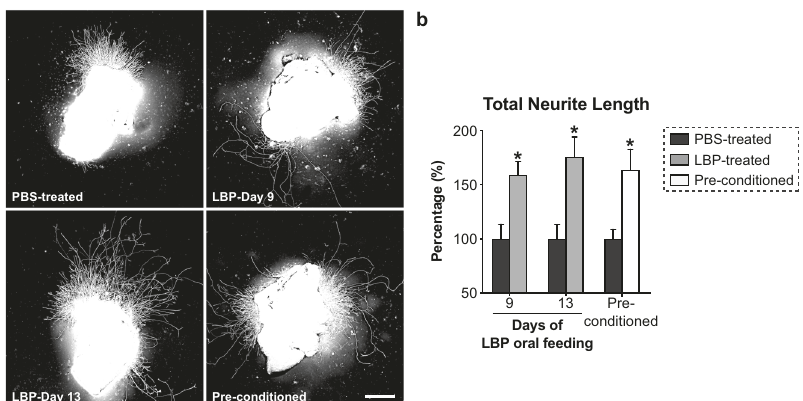
Fig. 1 LBP induces intrinsic growth capacity of axotomized dorsal root ganglion (DRG) neurons in ex vivo explant cultures. Adult male C57BL/6 mice were orally administrated with 100 mg/kg LBP (or PBS as vehicle controls) for 9 and 13 consecutive days. For pre-conditioning DRG explant cultures, the left sciatic nerve was transected, and lumbar 3, 4, and 5 (L3/4/5) ipsilateral DRGs were harvested at 5 days post- injury, and cultured on a poly-D-lysine-coated 8-well chamber with a thin layer of Matrigel for 48 h. Cultures were fi xed and immunostained with anti- β III-tubulin antibodies for neurite outgrowth assay. a Representative fl uorescent micrographs showed that DRG explants treated with LBP for 9 and 13 days induced robust neurite extension compared to the PBS-treated controls. Scale bar: 500 μ m. b The average total neurite length was quanti fi ed by automated WIS-Neuromath software. LBP increased neurite outgrowth of DRG explants signi fi cantly, with its maximal effect at day 13. The total neurite length of LBP-treated DRG explants (13-day treatment) was comparable with pre-conditioned DRG explants. Mean ± SEM ( n = 6 – 8 per group); * P < 0.05, one-way ANOVA followed by post hoc Bonferroni